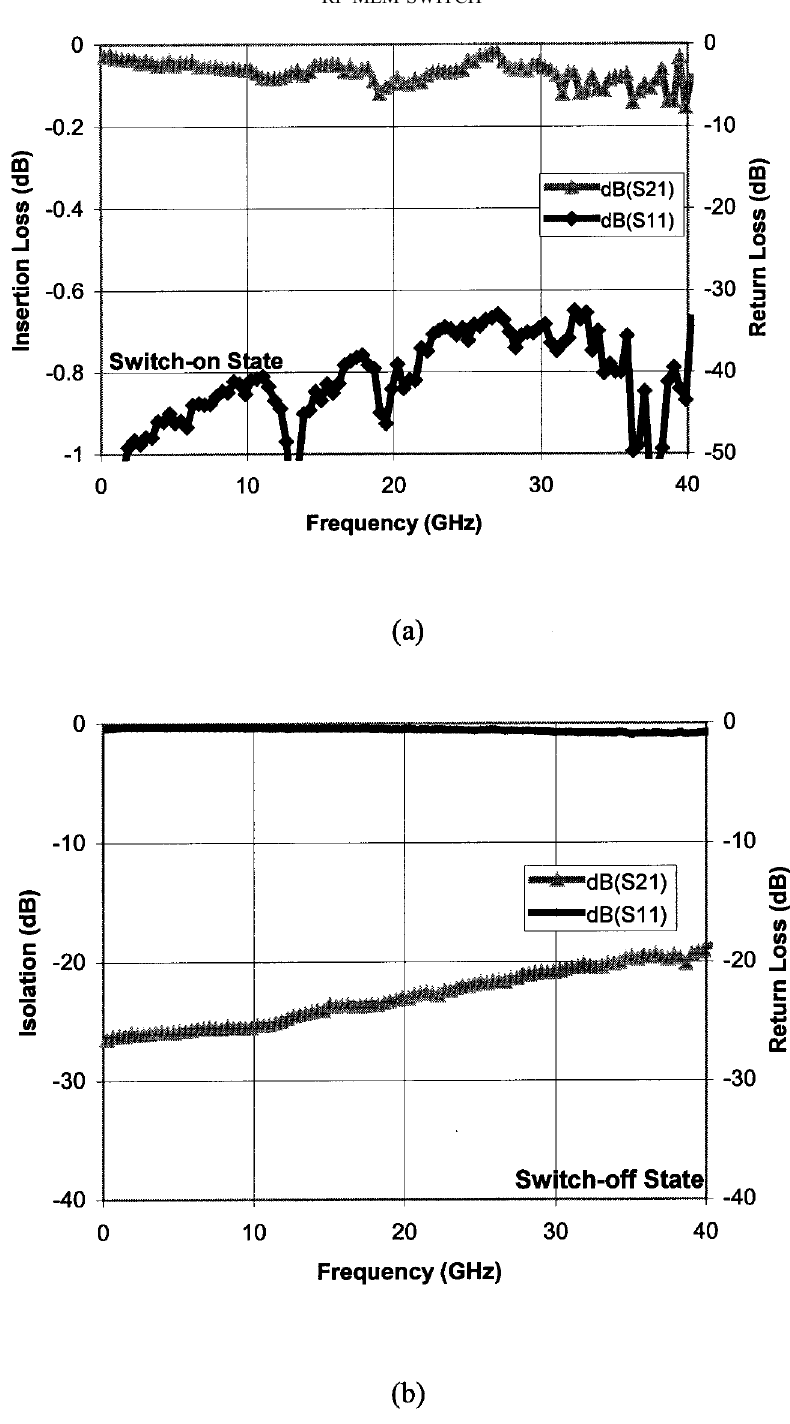
FIGURE 6 Measured RF performance for a cantilever switches for (a) switch-on state and (b) switch-off